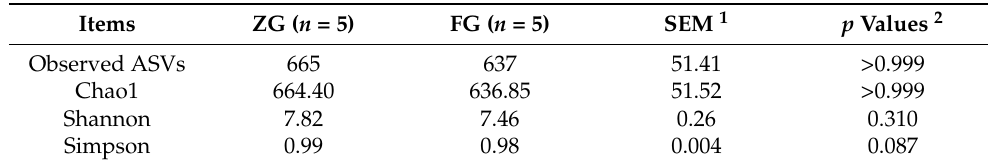
Table 4. ASVs and cecal microbial alpha diversity, including the Chao1, Shannon, and Simpson indexes, for the ZG and FG.